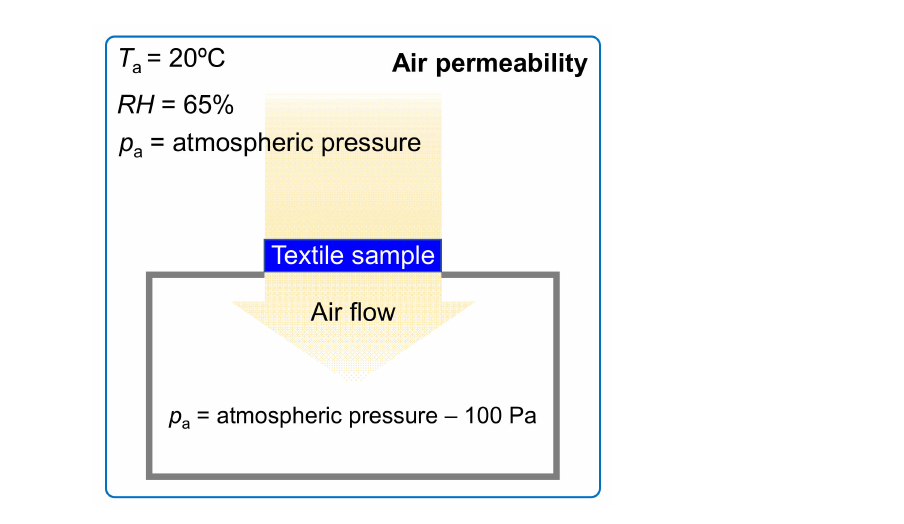
Figure 6. Conditions for textile air permeability measurements.